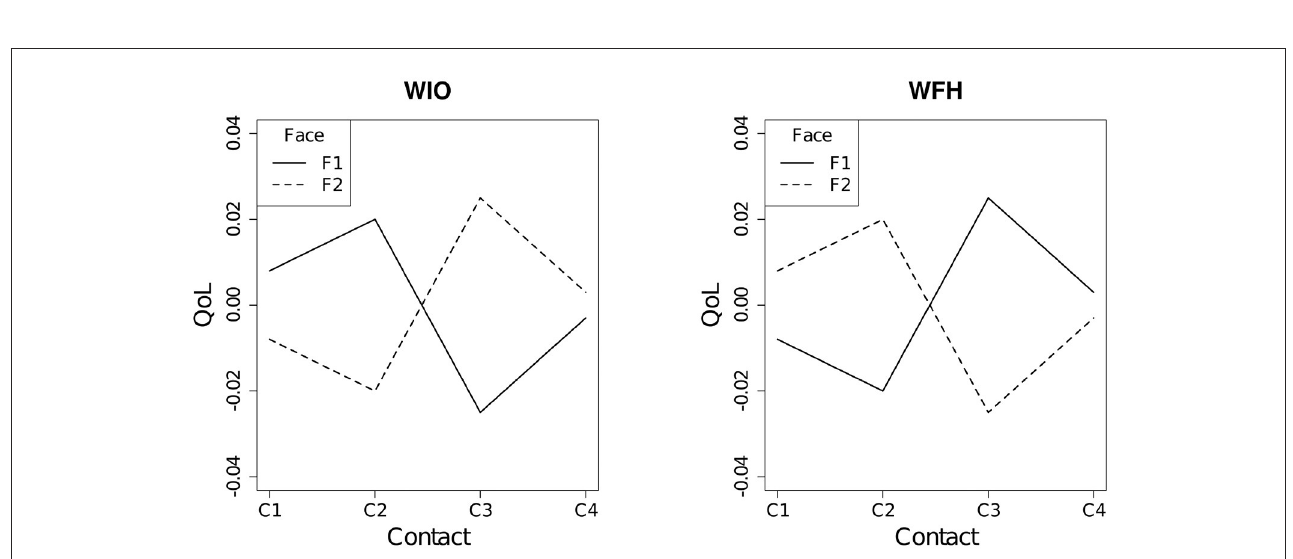
FIGURE3 Interaction plot between the social contact quantity and the face-to-face contact ratio for the WIO (left) and WFH (right)